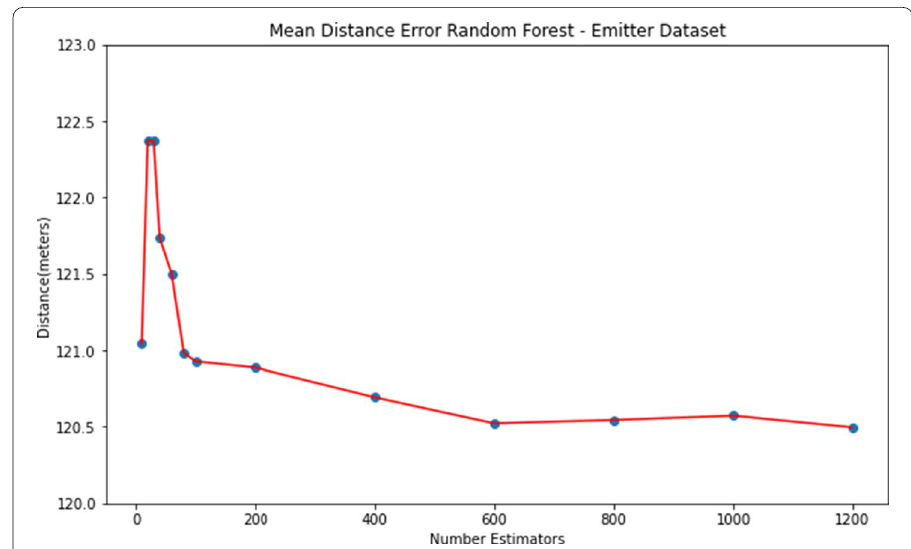
Fig. 12 Estimating model’s error on emitter dataset for random